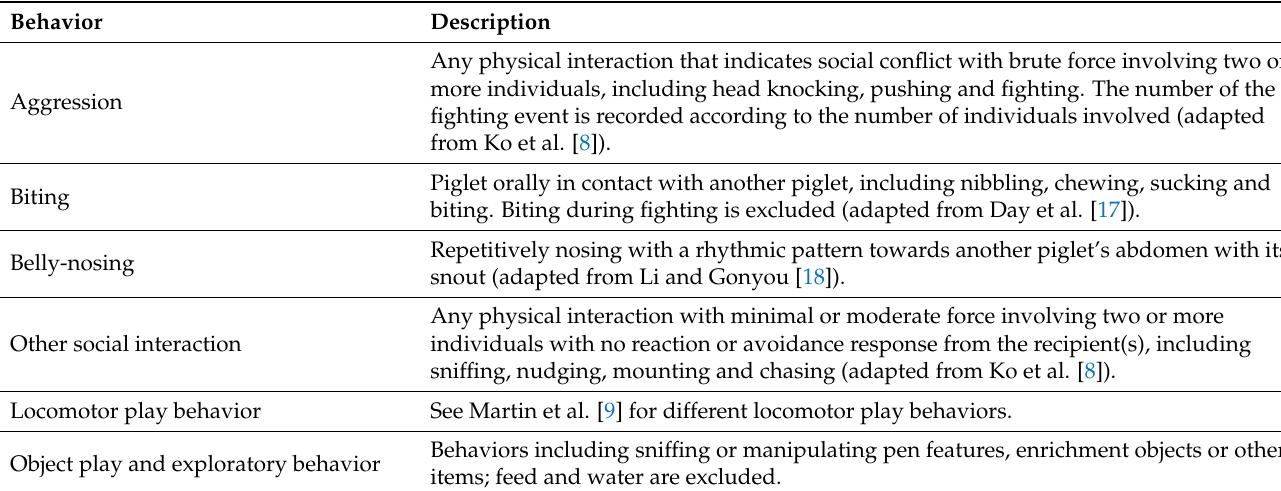
Figure 1. Distribution of ( a ) sows and ( b ) piglets after weaning in four batches, including 14 group pens for the sows and 16 nursery pens for the piglets, which are highlighted in thick lines. (FC: pigs that were housed in the conventional farrowing pens with a farrowing crate before weaning; SWAP (Sow Welfare and Piglet protection) and JLF15: pigs that were housed in two types of farrowing pens with temporary crating before weaning.) n indicates the number of the sows or piglets in one pen. A pen that has sows/piglets originating from more than one farrowing system is considered as the “surplus sows/piglets”, and they are discarded from the study after weaning.5. Table 1. Behavior categories for post-weaning